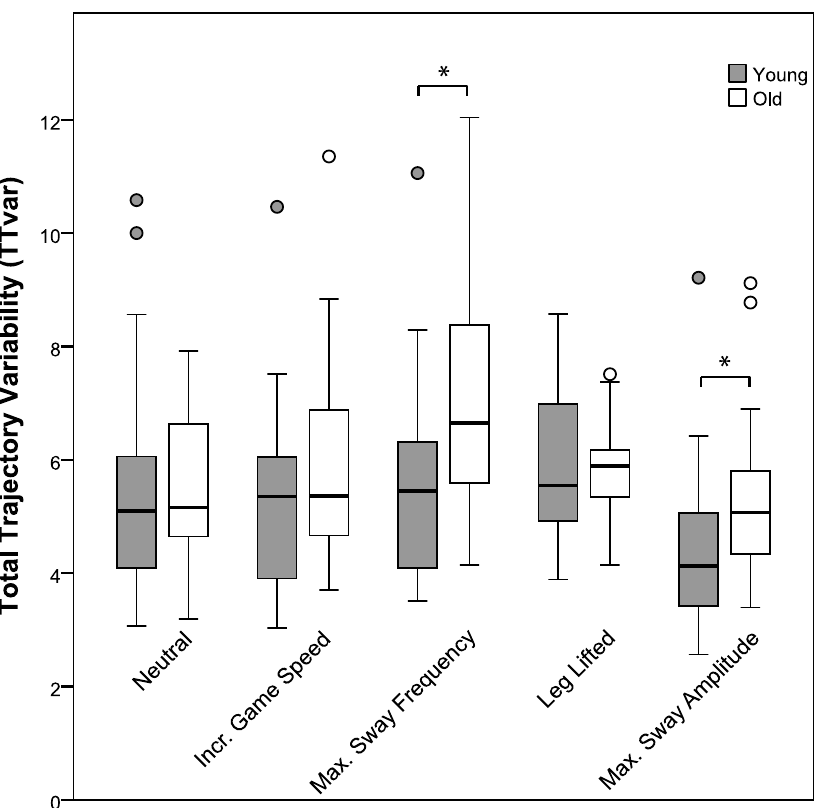
Fig 3. Total trajectory variability (TTvar) of young and older adults in exergame tasks of varying complexity. Total trajectory variability (TTvar) of young and older adults in the five different exergame tasks are displayed by the grey and white boxes, respectively. The line inside the box indicates the median of the sample while the first and third quartile are indicated by the lower and upper part of the box. The error bars represent the size of the range of the total sample, with the exception of outliers, which are indicated with a circle, and defined as samples that are further away from any end of the box than 1.5 times the interquartile range. Tasks on which the groups differ significantly are indicated with an asterisk. Note that TTvar is a measure of distance related to the nodes on the SOM, hence TTvar has no units.